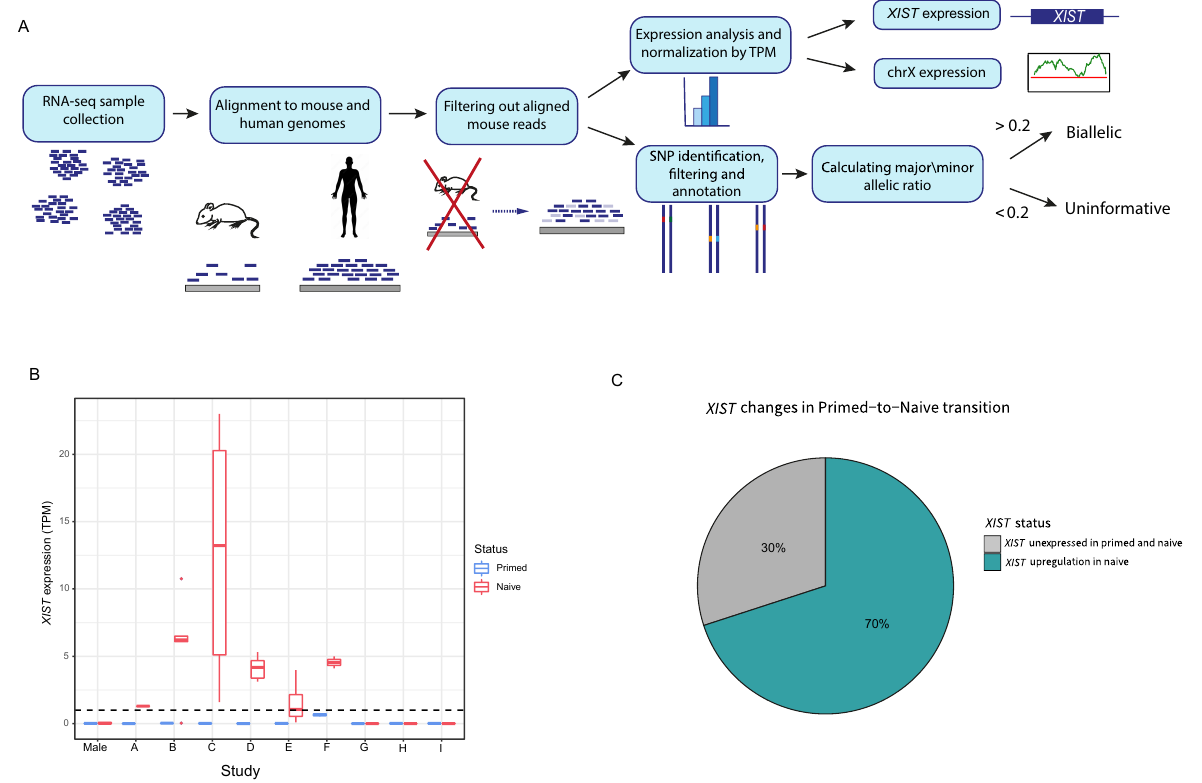
Figure 1. Primed and naïve hESC analysis and XIST expression. ( A ) Schematic representation of the pipeline of the analysis of expression of X-linked genes and their allelic expression. ( B ) XIST expression by TPM (transcripts per million) values in primed (blue) and naïve (red) hESCs